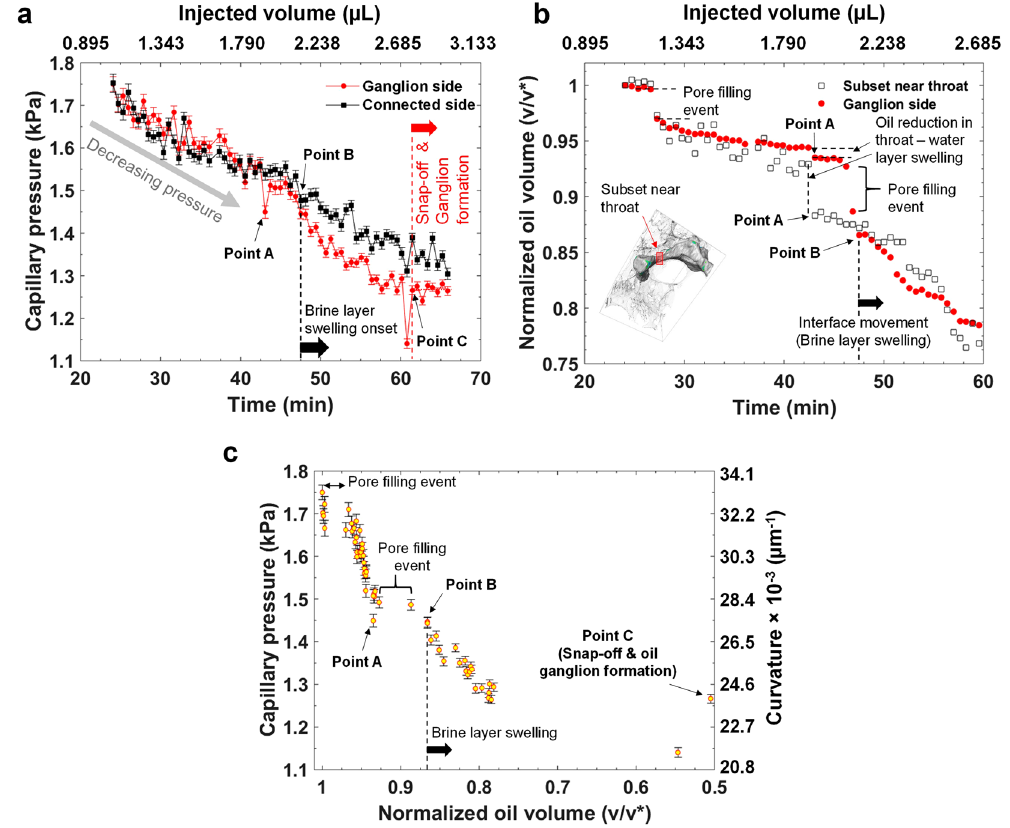
Figure 2. Local capillary pressure and oil saturation analysis during pore-filling and snap-off processes. ( a ) Capillary pressure, calculated from the total curvature using the Young-Laplace equation, is plotted against time and injected volume in the ganglion and connected side subsets that are shown in Fig. 1. ( b ) Oil volume (v) normalized to the oil volume (v * ) at t = 24 min 4 s in the ganglion-side subset and in a subset near throat (marked by a red box in the inset picture) as a function of time and injected volume. ( c ) Capillary pressure of the brine-oil interfaces in the ganglion-side subset as a function of normalized oil volume (v/v * ) in the ganglion-side subset. Here, the error bars in the capillary pressure are standard error in the mean with 95% confidence intervals calculated using ± 1.96 × σ / √ N , where σ is the standard deviation and N is number of points